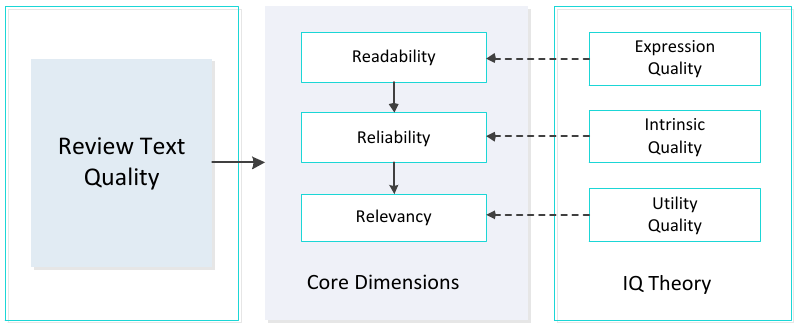
Figure 2. A framework for review text quality measurement.